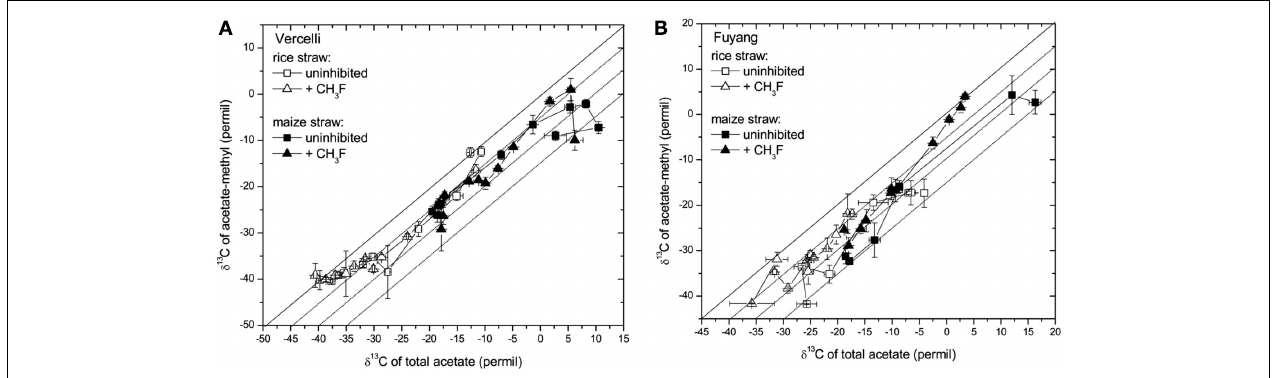
FIGURE 6 | Relation between the δ 13 C of acetate-methyl and the δ 13 C of total acetate measured in soil from (A)Vercelli, and (B) Fuyang, amended with either rice straw or maize straw and incubated under anoxic conditions in the absence or presence of CH 3 F (1 and 2% inVercelli and Fuyang soil, respectively); mean ± SE, n = 3.